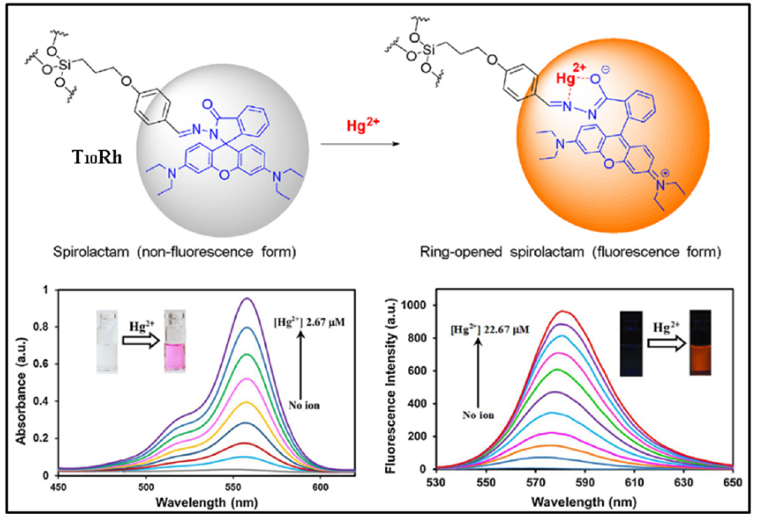
Figure 14. Schematic illustration of sensing mechanism of T 10 Rh toward Hg 2+ . The absorption spectra ( bottom left ) and PL spectra ( bottom right ) of T 10 Rh to different concentration 10% aqueous ethanol solutions of Hg 2+ [92].